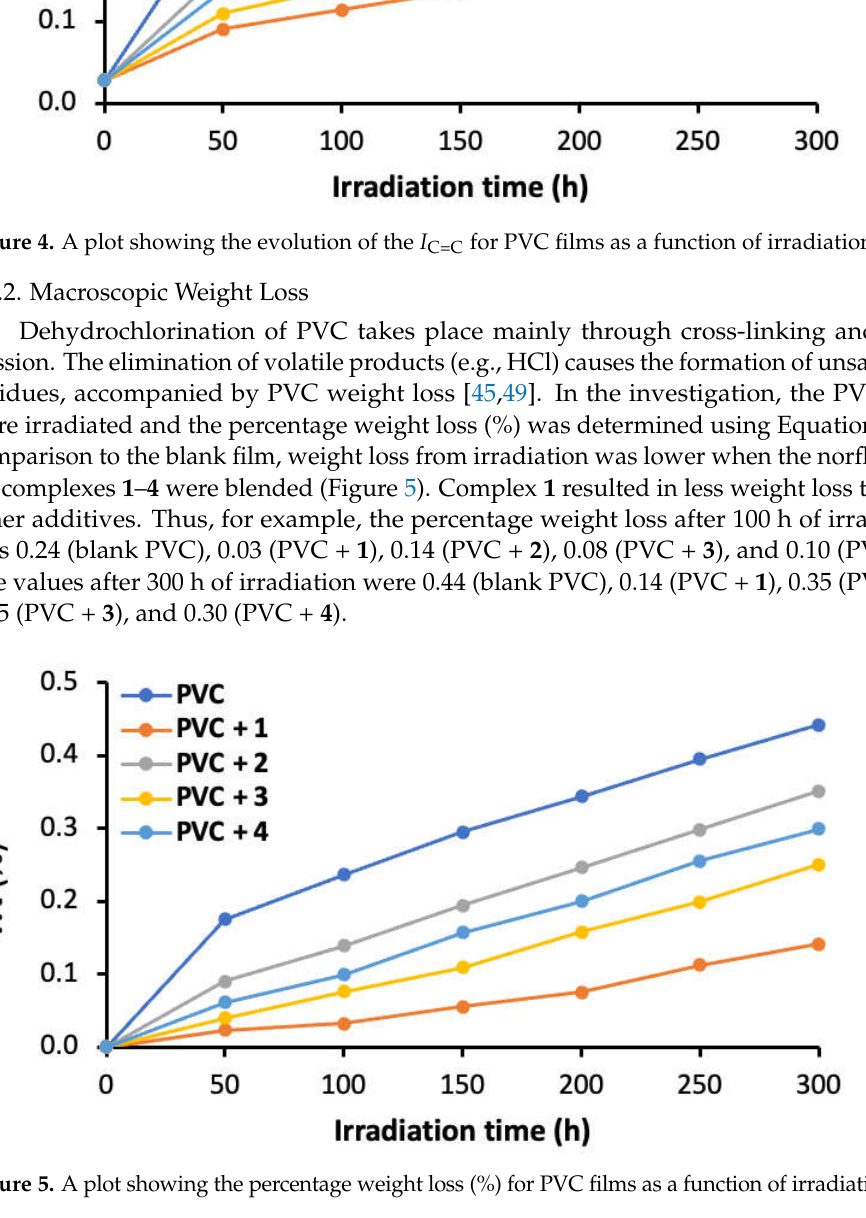
Figure 5. A plot showing the percentage weight loss (%) for PVC films as a function of irradiation